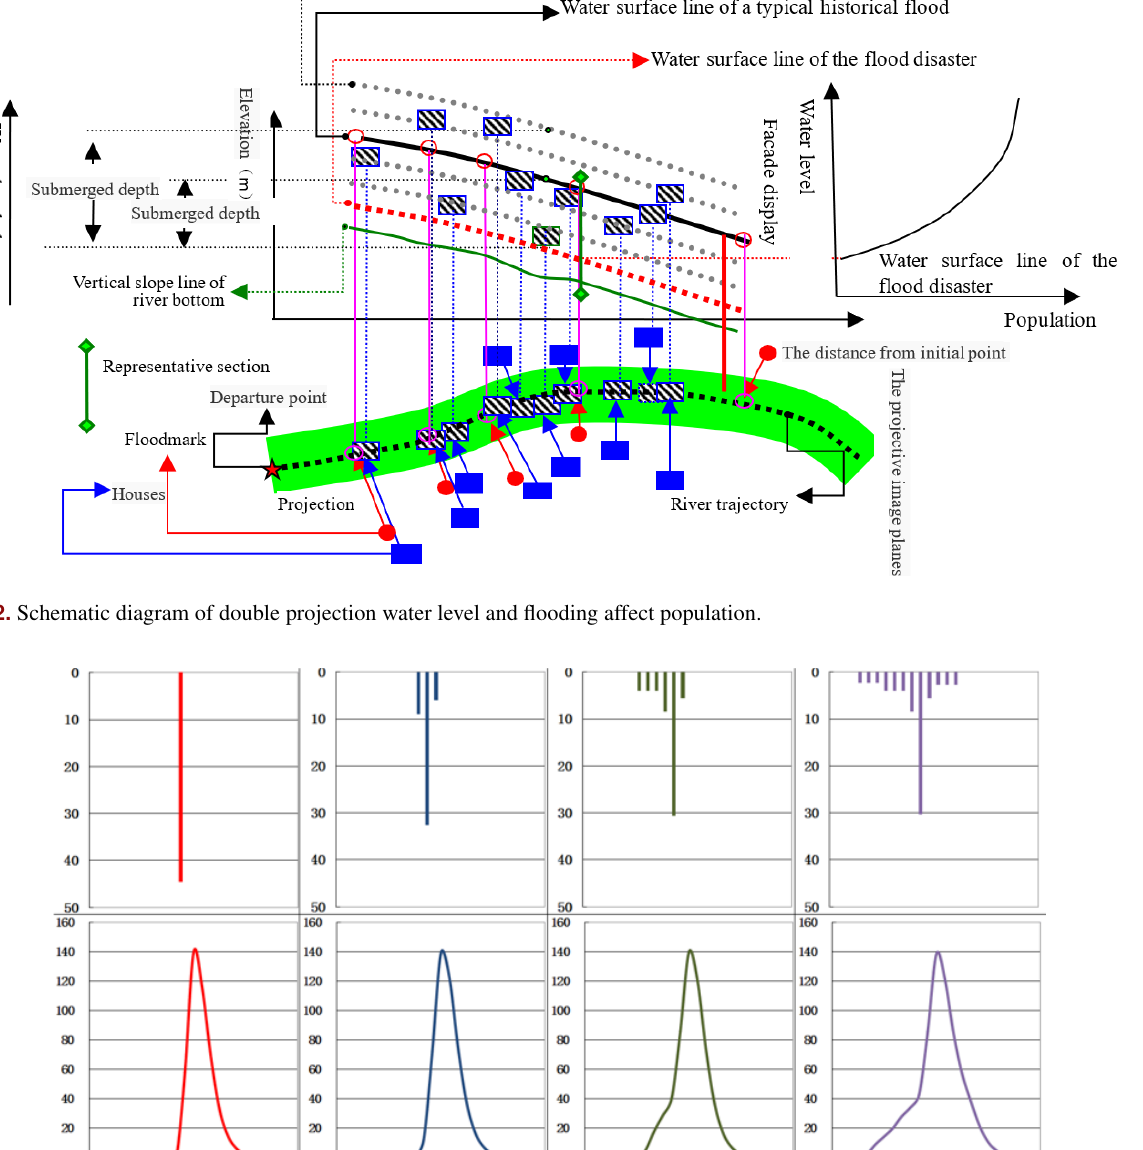
where n is Rainstorm attenuation index, 0 < n < 1; H t,p is the amount of rain that lasts for t and frequency p